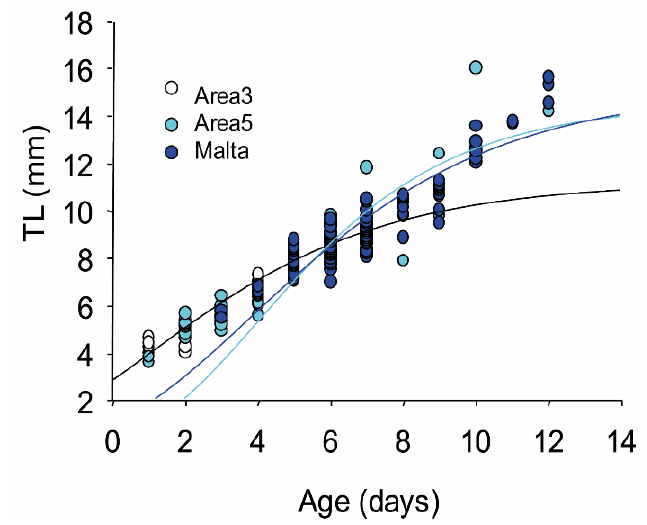
Figure 6 . Relationship between total length (TL) and age of larvae from areas 3, 5 and Malta. Lines represent curves fitted by Gompertz’s model by area.